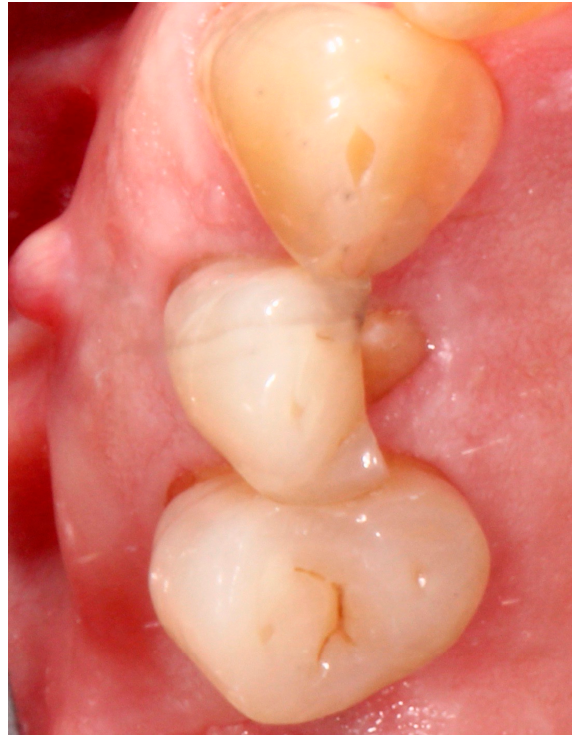
Figure 1. Clinical view of a 2.4 tooth presenting an endodontic failure with a buccal fistula.